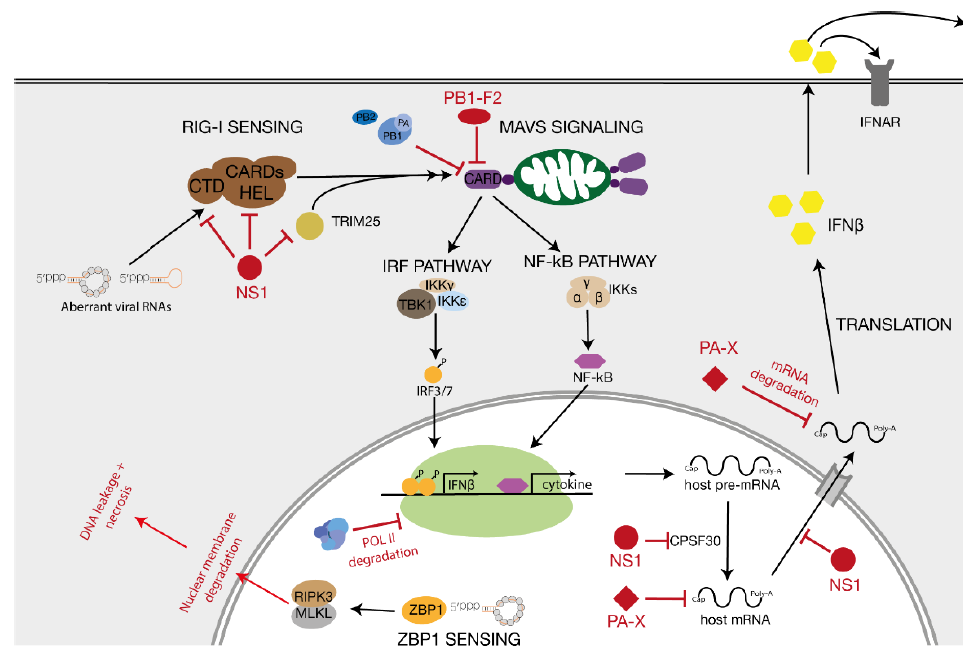
Figure 4. RIG-I and ZBP1 signalling after detection of influenza A virus RNA. After binding to aberrant IAV RNA molecules, RIG-I induces innate immune signalling via the MAVS signalling cascade. MAVS activates the IRF and the NF- κ B pathway which lead to the production of IFN β and inflammatory cytokines, respectively. ZBP1 binds viral RNA in the nucleus and triggers RIPK3 mediated necrosis. Viral antagonists PA-X, NS1 and PB1-F2 that block certain steps of the immune signalling pathways are also indicated.